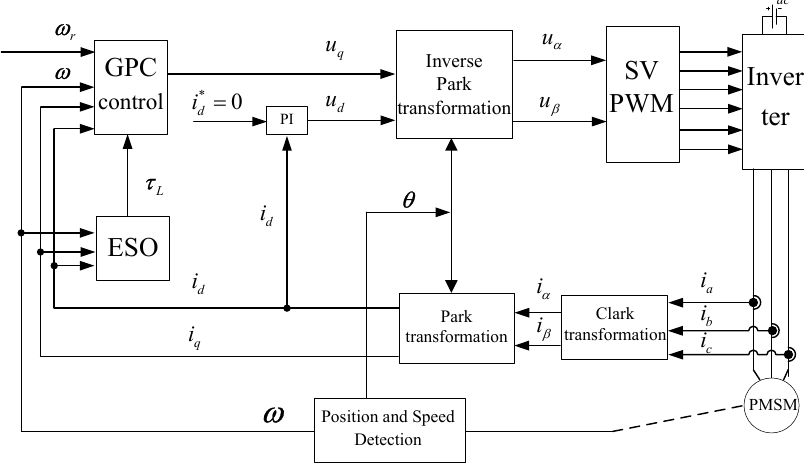
Figure 1. Control system diagram of the PMSM drive